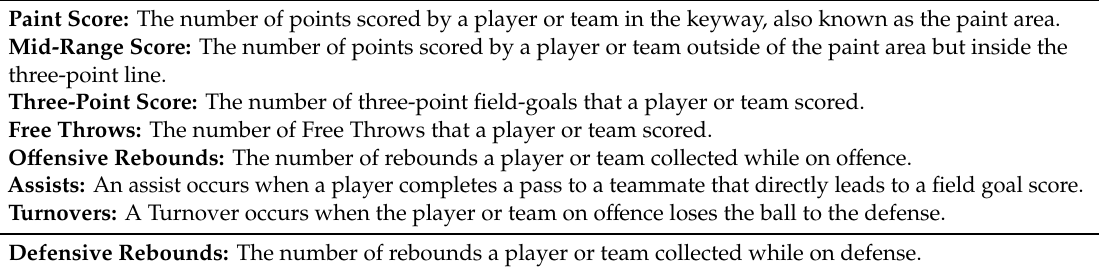
Table 1. The variables selected in the current